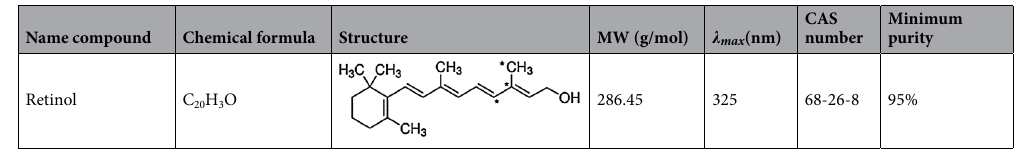
Table 1. Molecular structure of vitamin A 2 .